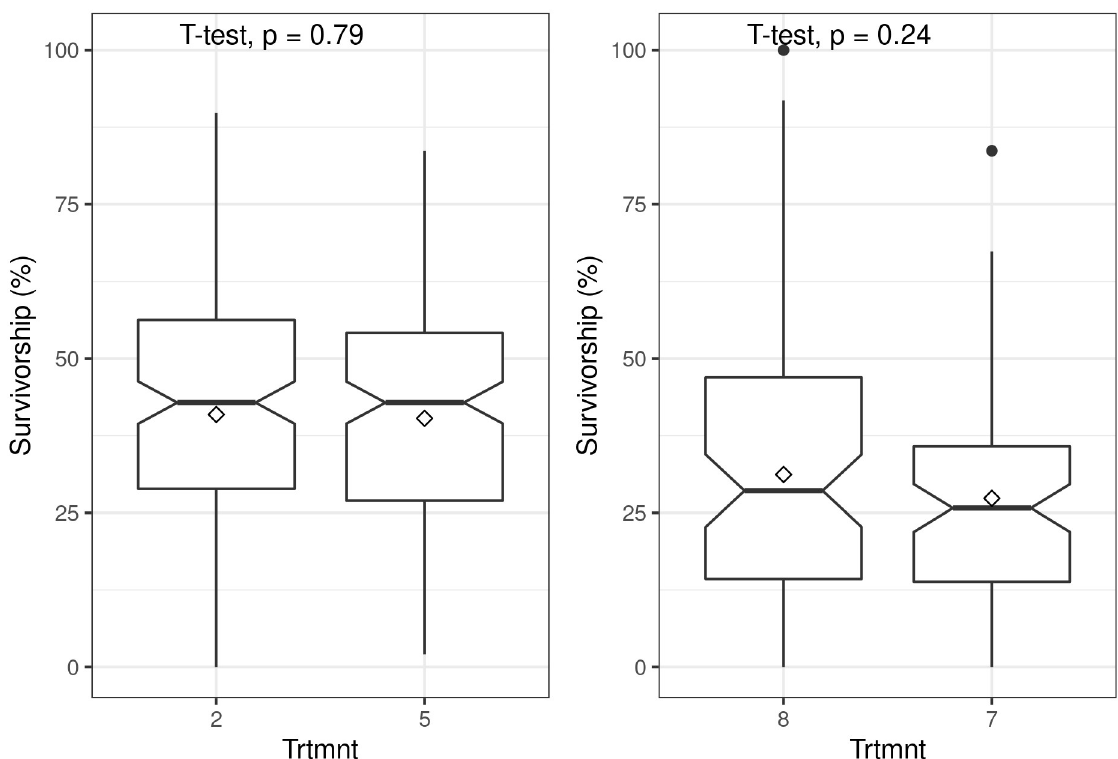
Fig 6. Boxplots showing the effect of water application at planting of spekboom ( Portulacaria afra ) truncheons on survivorship. The top panel is for 22.5 mm diameter truncheons and bottom panel is for 10 mm diameter truncheons, all planted at 1 m intervals. Treatments (Trtmnt) 5 and 8 had water application whereas treatments 2 and 7 had none (see Tables 1 and 2 for details). Within-box horizontal lines depict median values and the diamonds depict mean values.